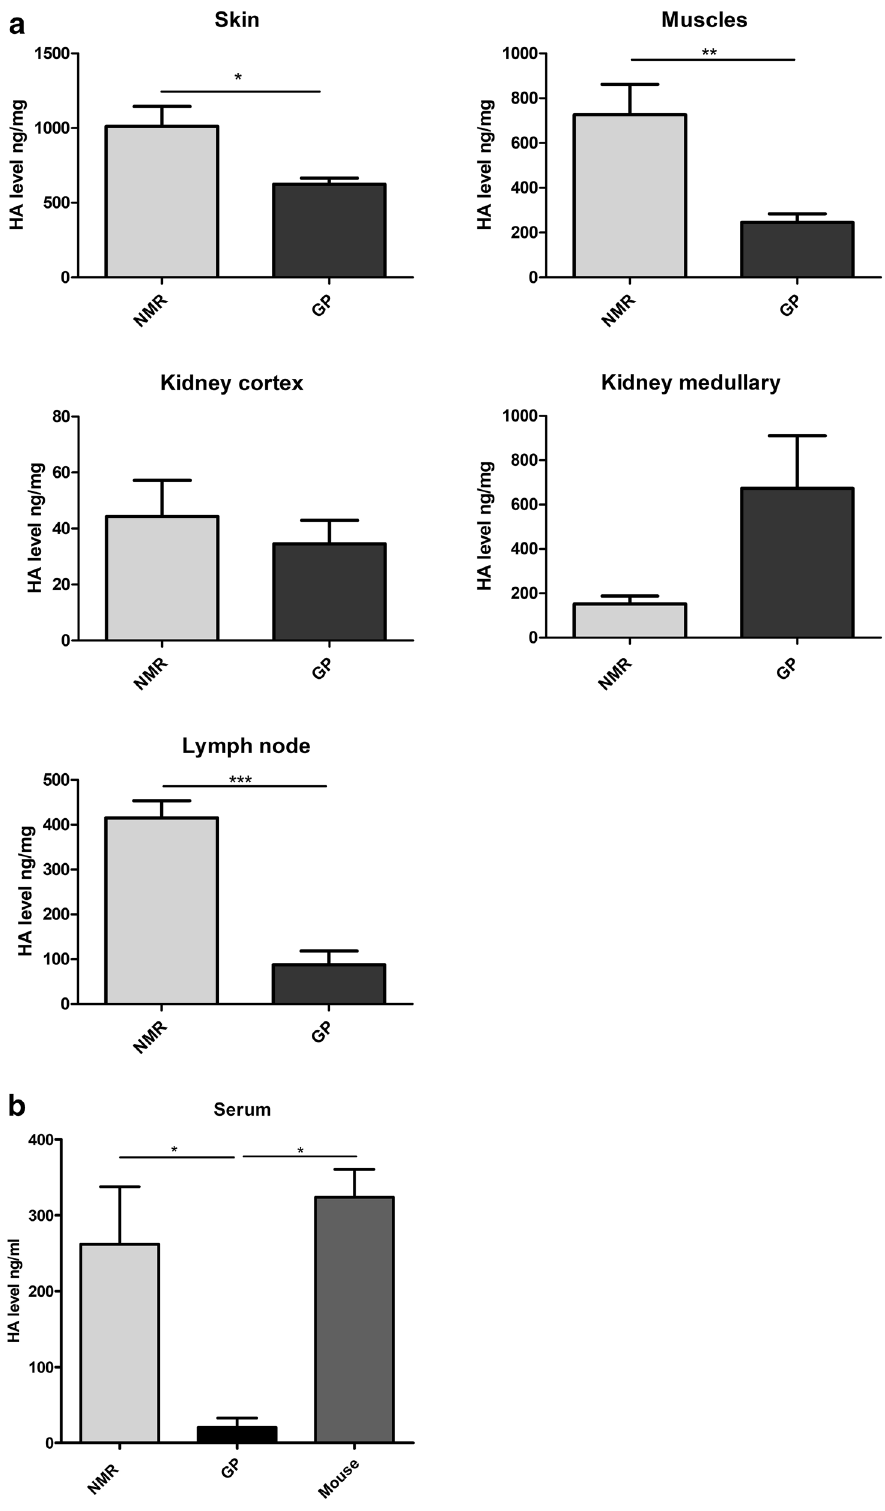
Figure 4. HA level in NMR and GP tissues and in NMR, GP, and mouse serum. ( a ) HA level (mean ± SEM) in NMR (n = 5) vs GP (n = 4) skin, NMR (n = 4) vs GP (n = 5) muscle, NMR (n = 4) vs GP (n = 4) kidney cortex and medulla, and NMR (n = 5) vs GP (n = 4) lymph node. ( b ) HA level in NMR (n = 8), GP (n = 4), and mouse serum (n = 4). Differences between NMR and GP are significant (***, P < 0.001; **, P < 0.01; *, P < 0.05) in skin, muscle, and lymph node (Student’s t test), and in serum (ANOVA followed by Holm-Sidak test; the difference between mouse and GP is also significant using that